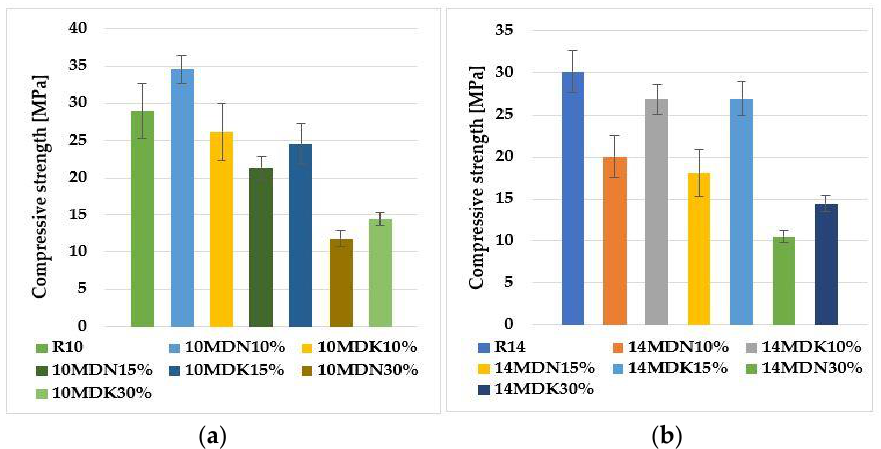
Figure 2. Compressive strength results for geopolymers based on calcium fly ash, sand, and calcined and non-calcined activated diatomite: ( a ) 10 mol alkali solution, ( b ) 14 mol alkali solution.